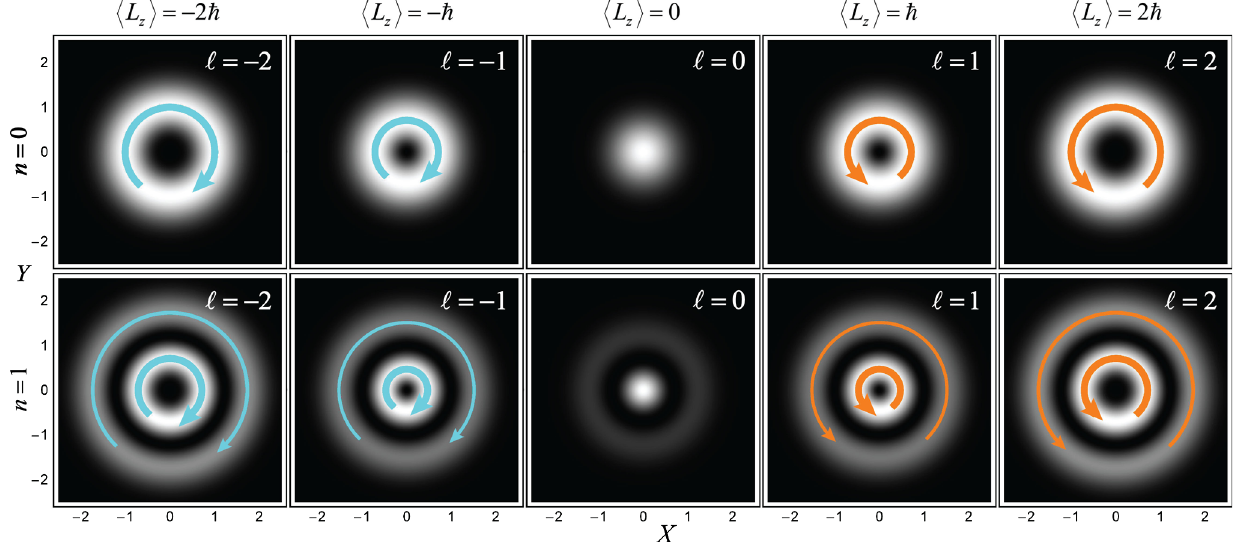
FIG. 3. Transverse probability-density distributions and azimuthal currents, Eqs. (13), for free-space LG beams (10) at z ¼ 0 with different OAM quantum numbers ‘ and radial indices n ¼ 0 (upper row) and n ¼ 1 (lower row). The dimensionless coordinates X ¼ x=w and Y ¼ y=w are 0 0